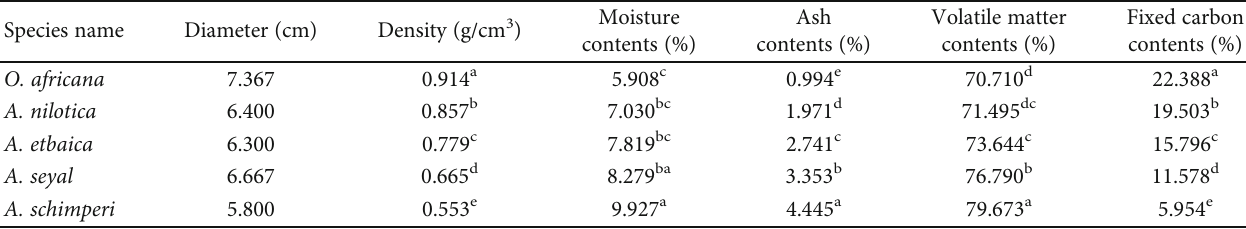
Table 2: Experimental results and principal component analysis (PCA) on fi ve tree species on their density and moisture, ash, volatile matter, and fi xed carbon contents.